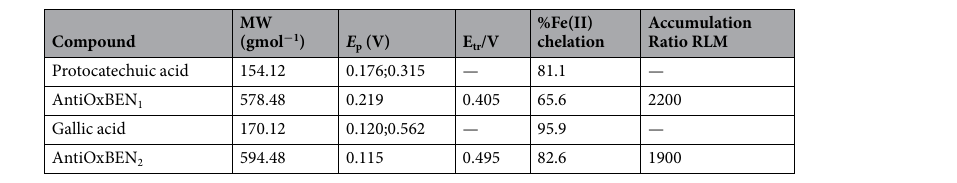
Table 1. Properties of hydroxybenzoic acids and mitochondria-targeted benzoic